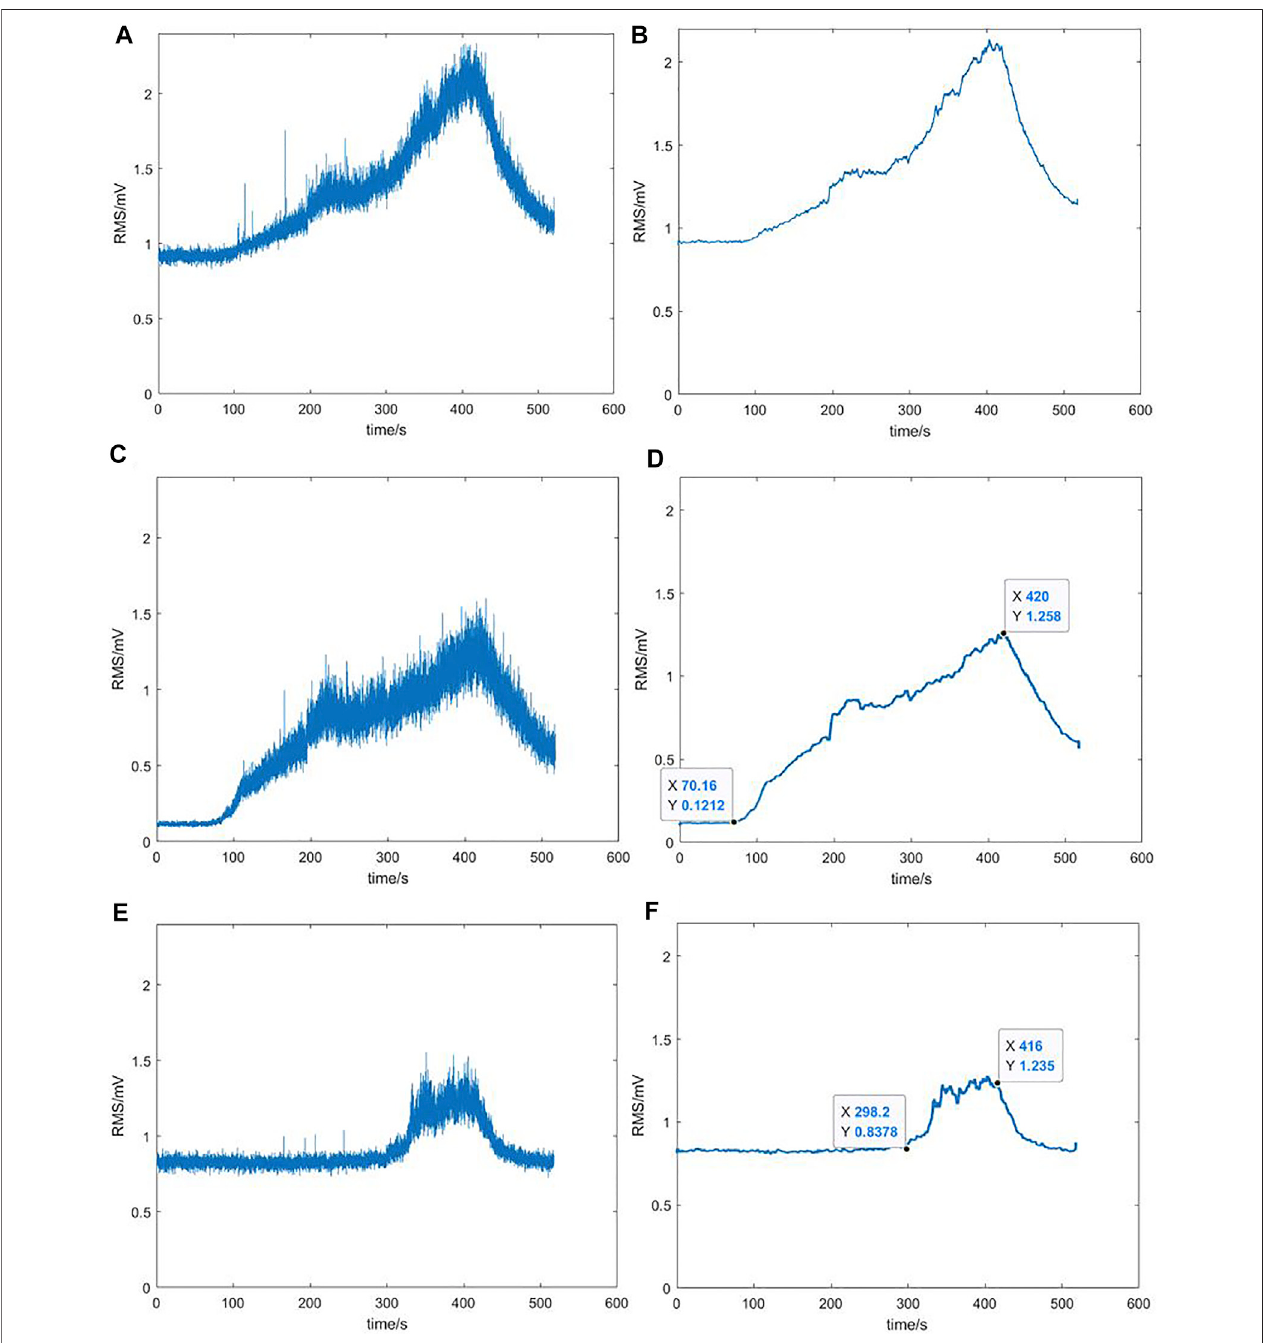
FIGURE8| Comparisonoforiginalandsmoothedacousticemissionsignalbeforeandafter fi ltering. (A) Originalsignal. (B) Smoothedsignal. (C) Originalsignalafter bandpass fi ltering. (D) Smoothed signal after bandpass fi ltering. (E) Original signal after lowpass fi ltering. (F) Smoothed signal after lowpass fi ltering.